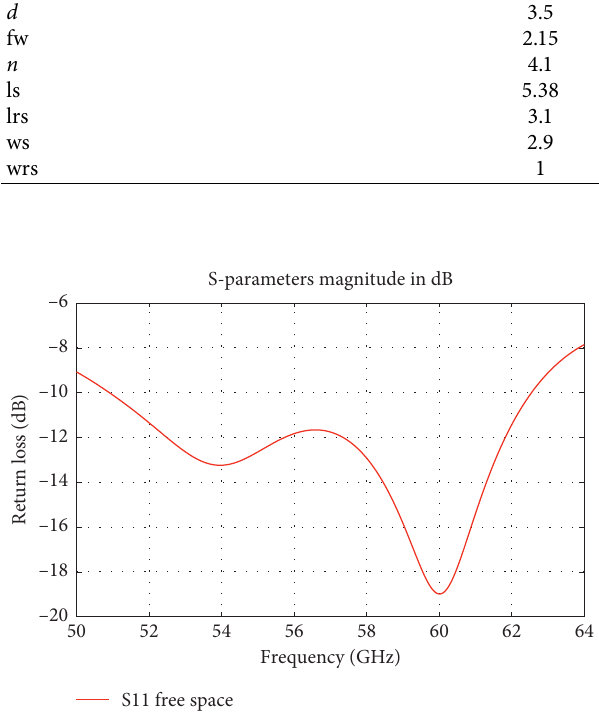
Figure 2: Return loss of the antenna in free